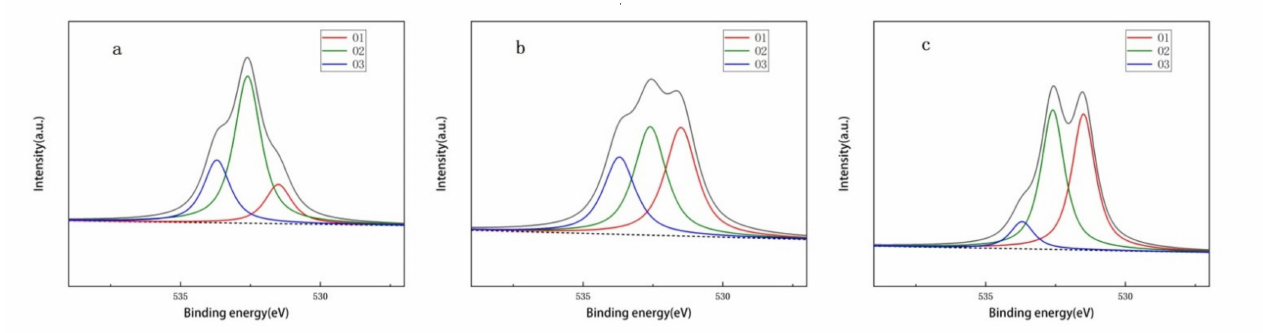
Figure 3. O1s XPS spectra of ( a ) RCB800, ( b ) BSB800, and ( c )